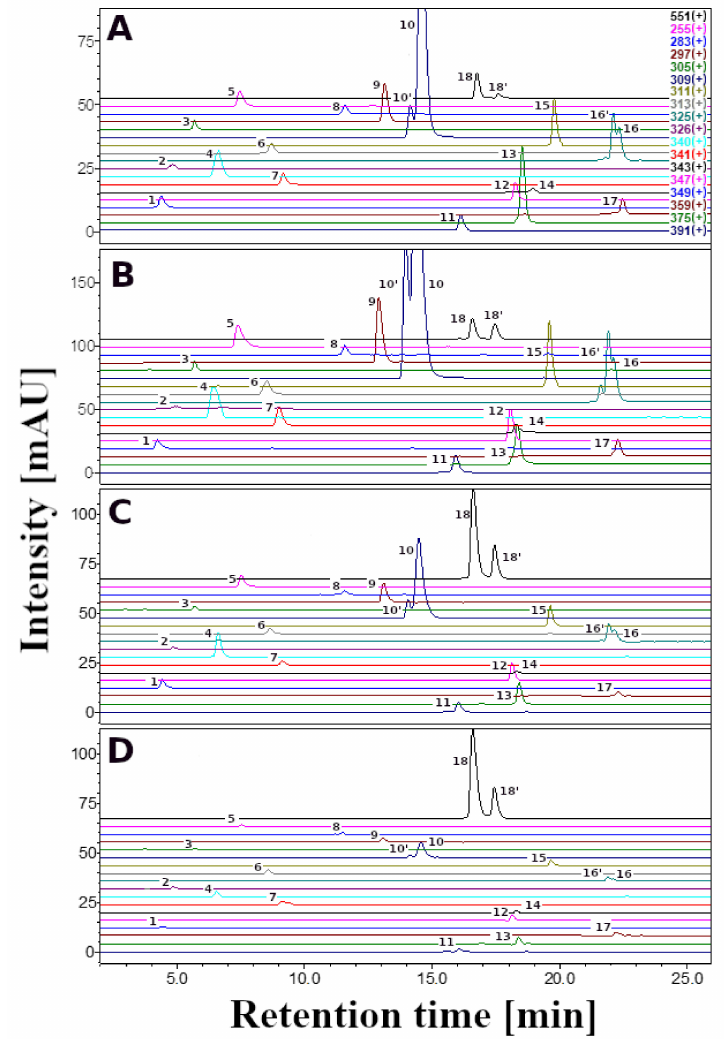
Figure 2. Selected-ion monitoring chromatogram (ESI-MS) in positive ion mode for betalains from P. grandiflora : ( A ) yellow; ( B ) orange; ( C ) red; ( D )